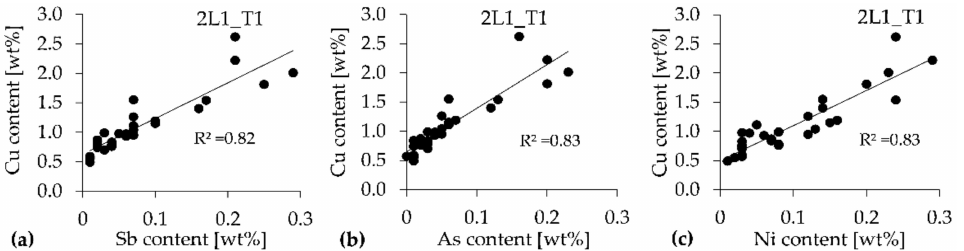
Figure 5. Copper content is plotted against ( a ) the antimony content; ( b ) the arsenic content; ( c ) the nickel content in vertical slag